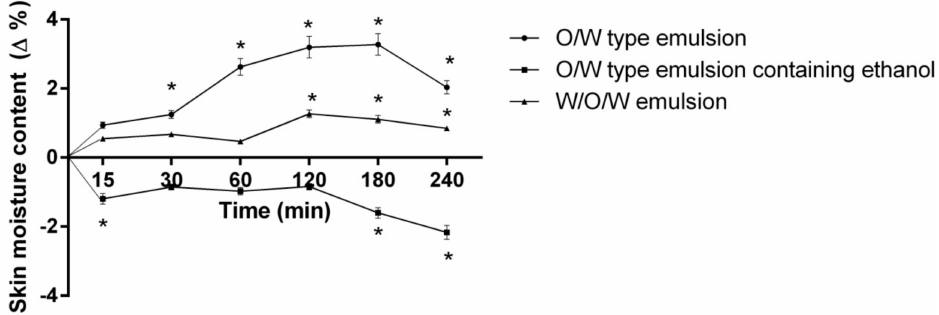
Figure 2. The influence of the investigated emulsions on the skin moisture content within 240 min. * p < 0.01 vs. 0 min. N = 51